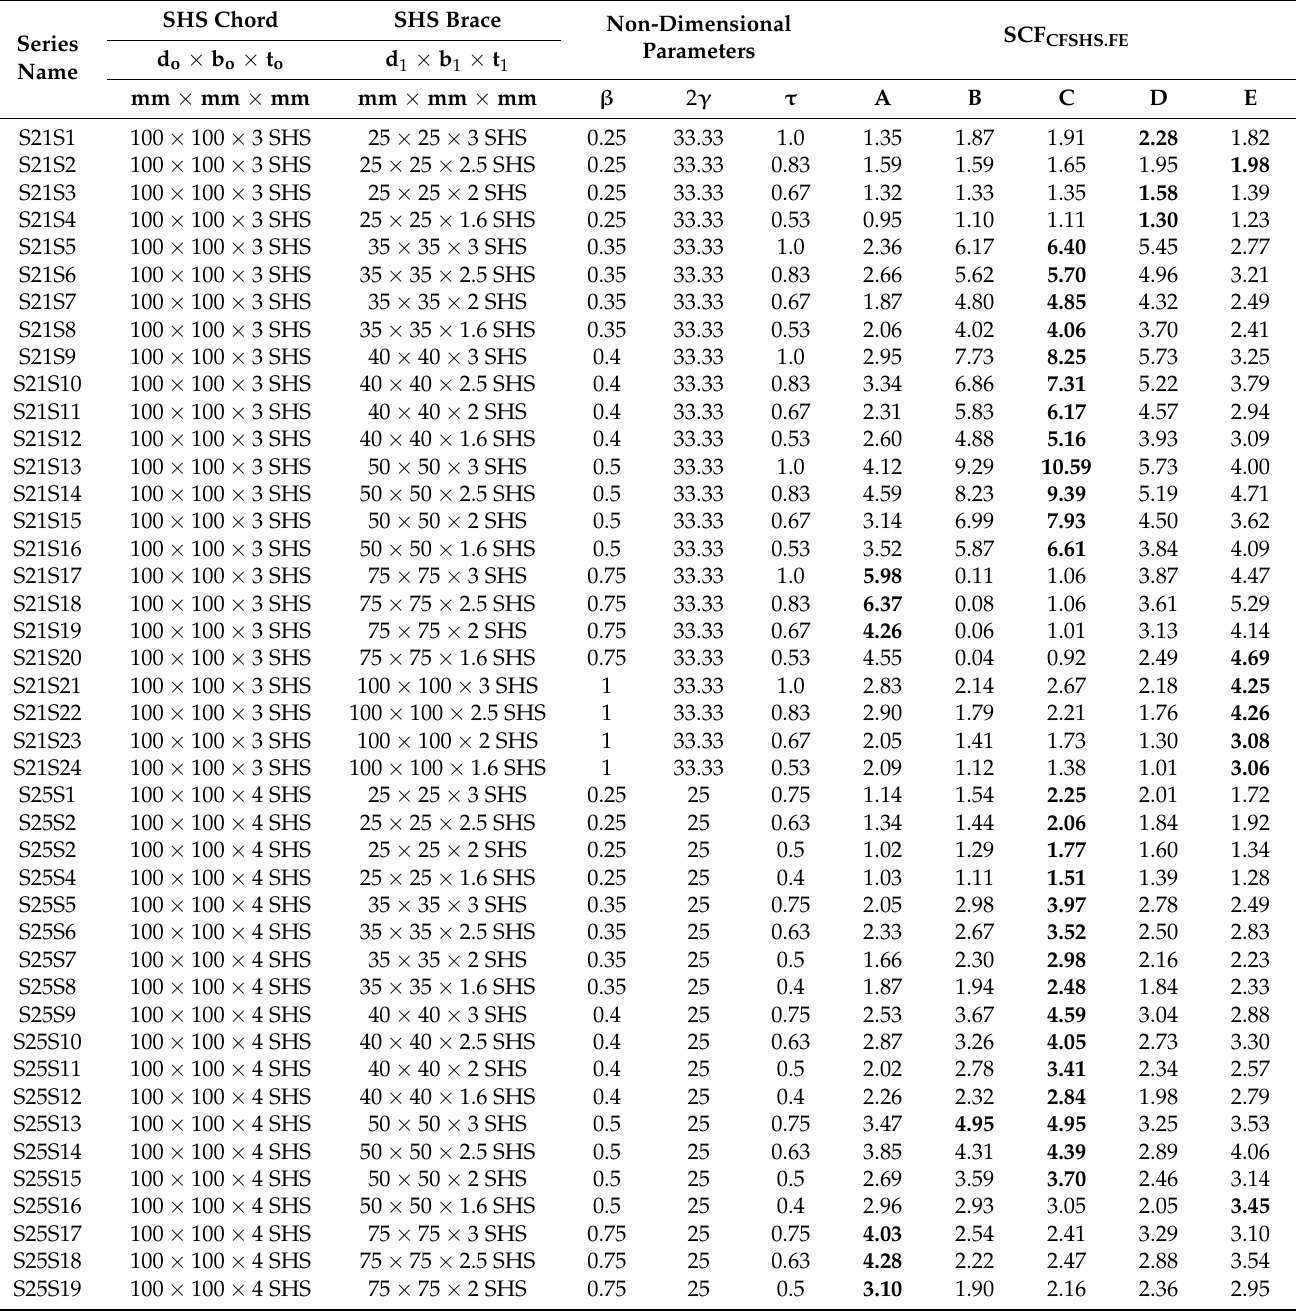
Table 10. SCFs obtained from